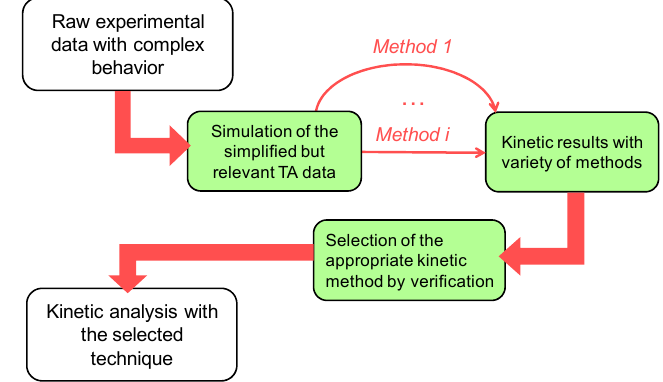
Figure 7. Proposed framework for the kinetic analysis of complex multistep processes.